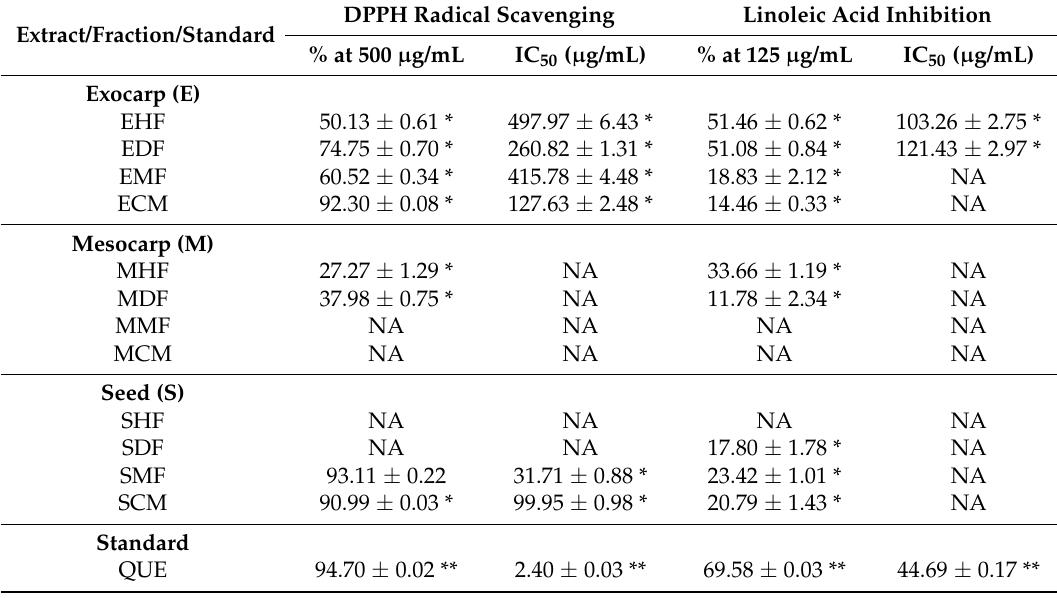
Table 2. 2,2-Diphenyl-picrylhydrazyl (DPPH) radical scavenging and linoleic acid peroxidation inhibition activities of D. indum